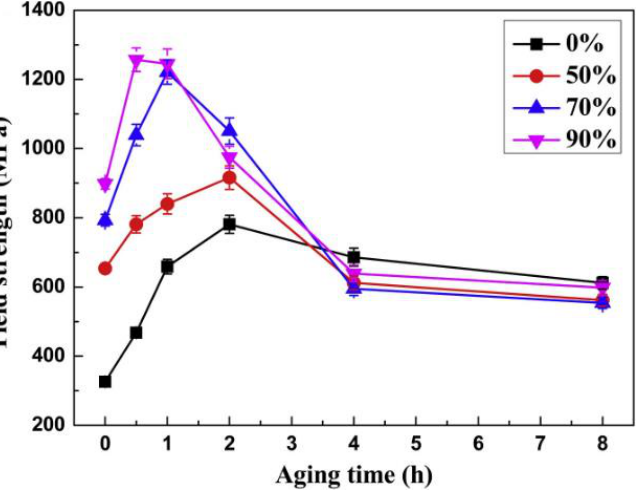
Figure 12. The variations in yield strength versus aging time after aging treatment at 400 °C [45]